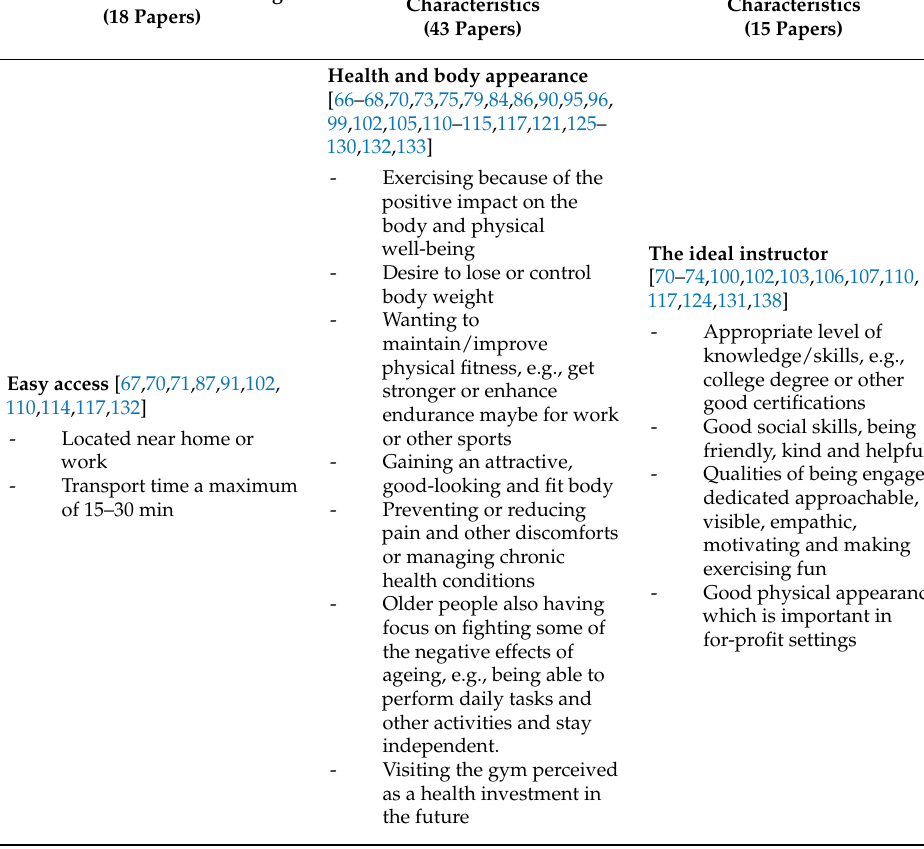
Table 6. Facilitators of exercising for adults without physical disabilities (AwoPD) distributed across the six modified context factor categories. Numbers in parentheses in the coloured cells refer to the total number of different papers (references in the square brackets) informing each of the six categories. 1. The Fitness Centre Setting (18